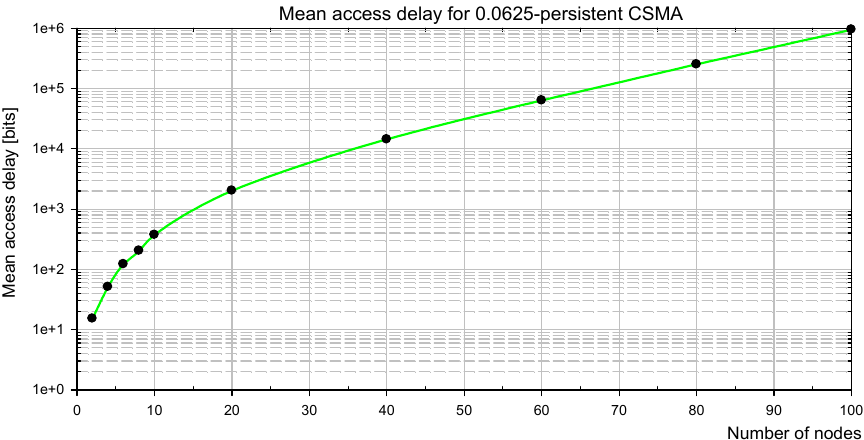
Figure 4. The mean access delay versus the number of nodes for 0.0625-persistent